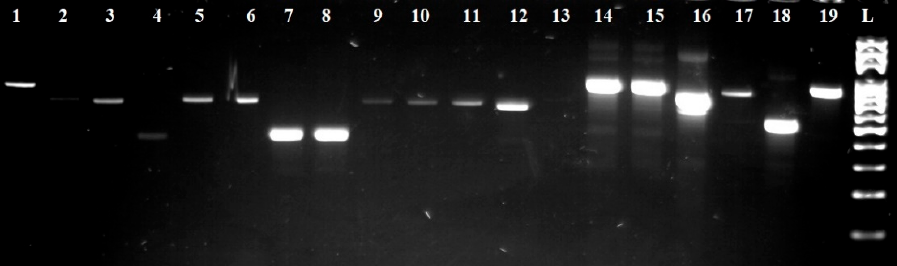
Figure 3. Electropherogram of a PCR reaction using ITS1/ITS4 primers. L: 100 bp ladder; lines 1, 14, 15, and 19: isolates Saccharomyces cerevisiae ; lines 2 and 16: isolates Hanseniospora uvarum ; lines 3, 5, 6, and 9–12: isolates Candida tenuis ; line 4: isolates Metschnikowia pulcherrima ; lines 7, 8, and 18: isolates Pichia sp.; line 17: isolates Torulaspora delbrueckii .